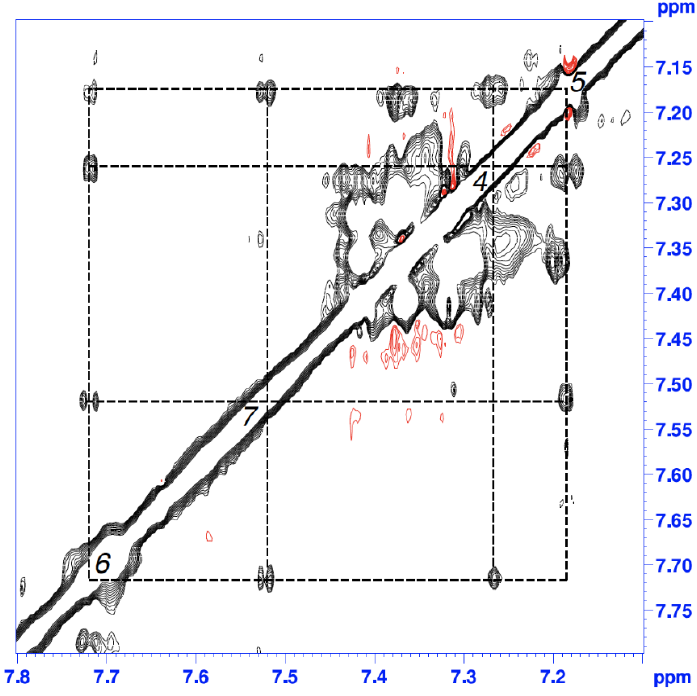
Figure 2. TOCSY spectra of Dybsort porter beer showing the indole signals. Numbers in italics refer to the position in the indole ring.